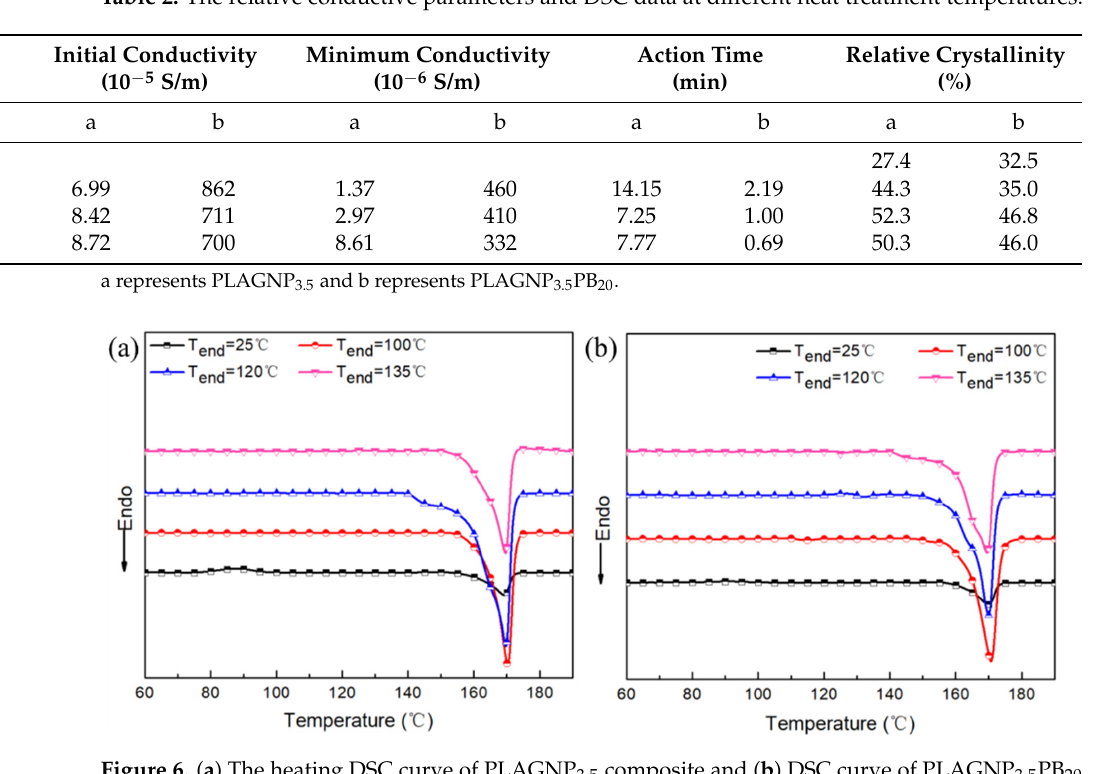
Table 2. The relative conductive parameters and DSC data at different heat treatment temperatures.